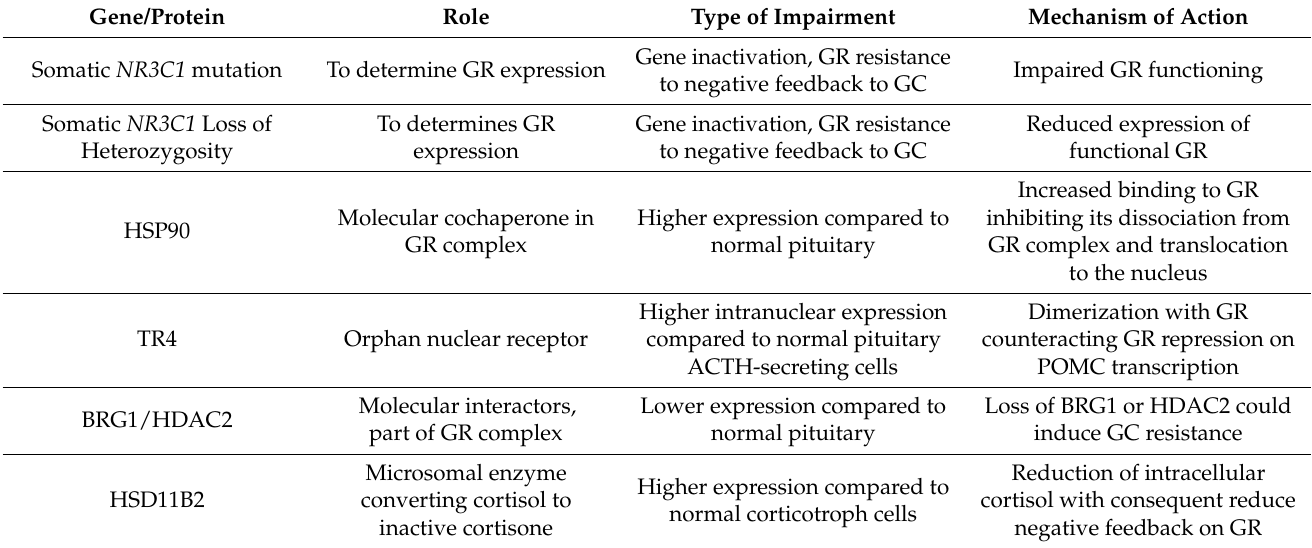
Table 1. Schematic summary of the main factors that might influence GR action, their physiological role, and the mechanisms by which they impaired GC sensitivity at pituitary